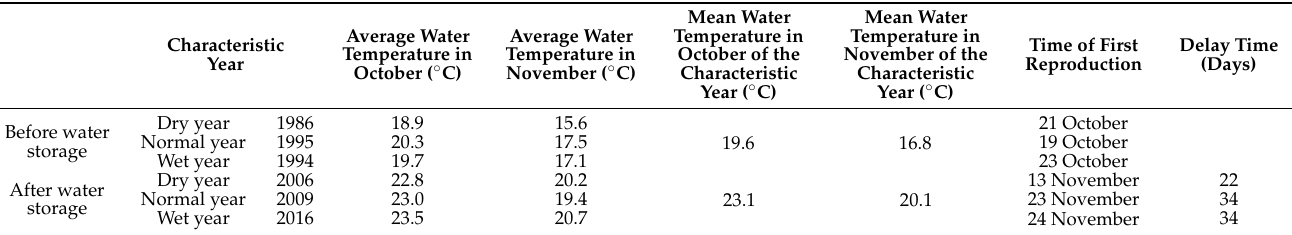
Table 7. Chinese sturgeon breeding